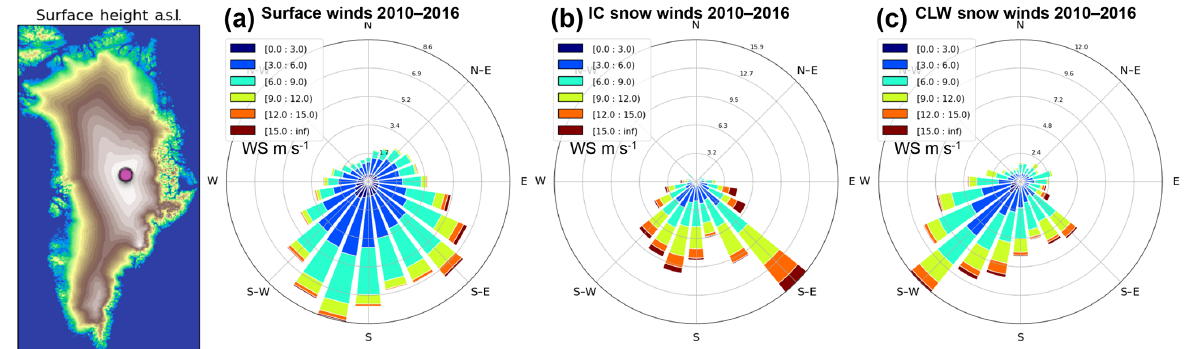
Figure 9. Figure showing the surface height of Greenland, created using measurements taken during the IceBridge campaign (a) . The surface height combines the contributions from both the bedrock and ice sheet topography. Surface winds from the Summit NOAA meteorological data are shown. For reference, (a) shows all surface winds from 2010–2015 for all times. Panel (b) shows the surface winds for the MWR- determined IC snow cases. These winds tend to come out of the southeast with little variability and are much stronger than the average winds. Panel (c) shows the surface winds for the MWR-determined CLW containing snow cases. Associated winds tend to be from the west to south with a maximum amount from the southwest direction. Though the CLW snow cases have stronger winds than average, they are not as strong as the winds associated with the IC